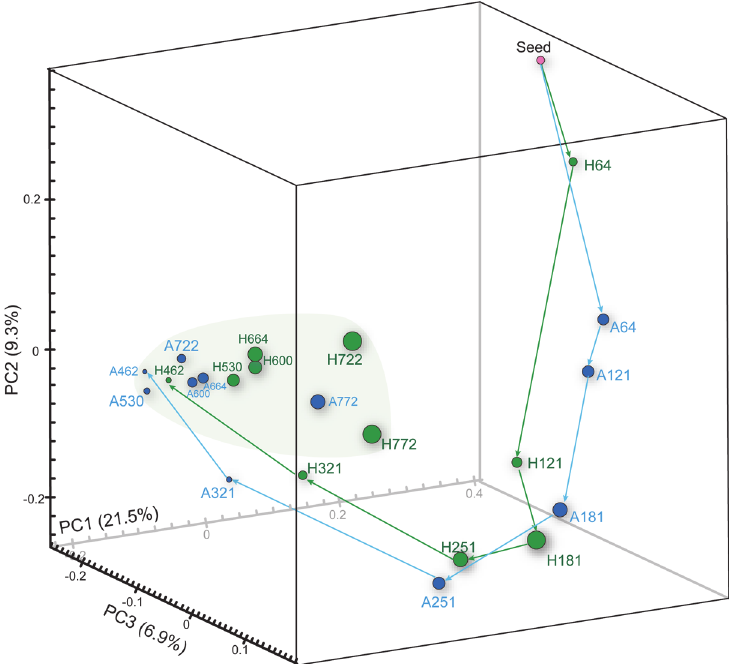
Fig 3. Principal coordinate analysis based on the abundances of 16S rRNA gene OTUs (unweighted UniFrac). For this analysis, observed 16S rRNA gene OTUs were normalized to 1,400 reads per sample. A and H indicate the samples taken from the anaerobic packed-bed (AP) and hybrid packed-bed (HP) reactors. The numbers following A and H indicate days of the operation for biomass sampling.